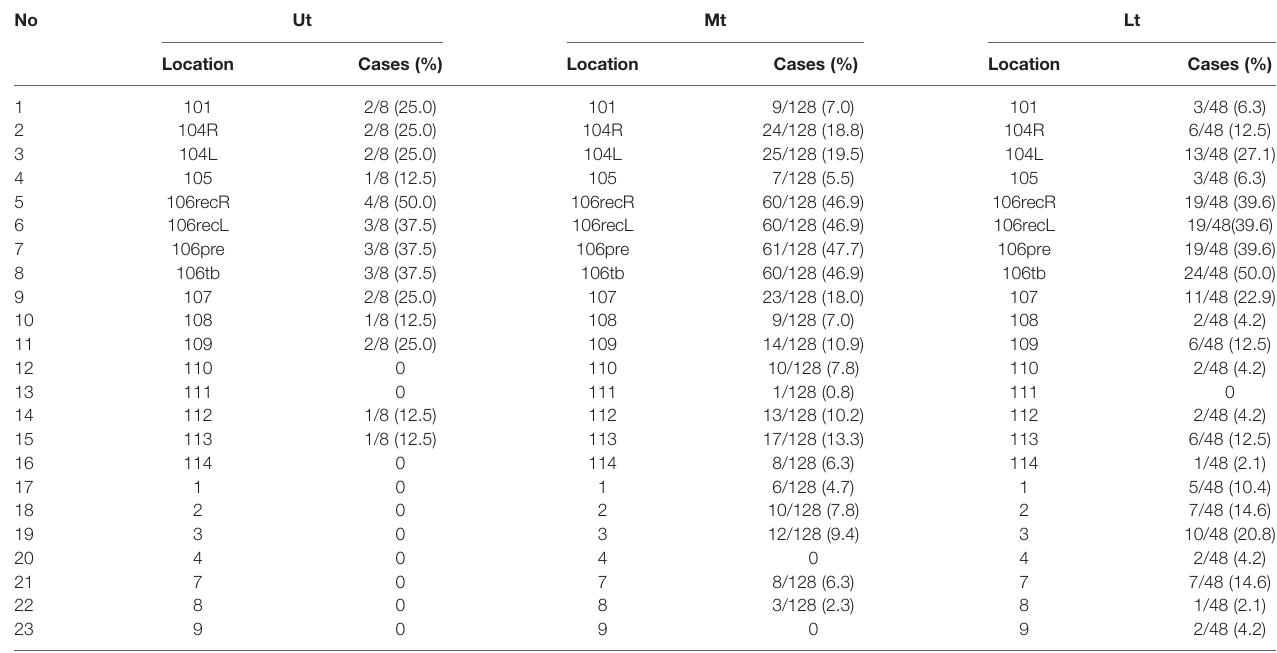
TABLE 2 | The LNR rate in different locations of thoracic